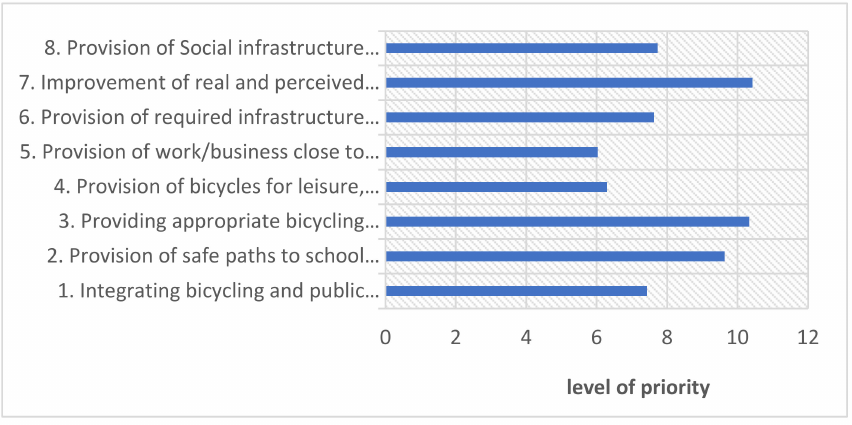
Figure 9. Level of priority (mean of the scores) for design provisions according to the pre-workshop